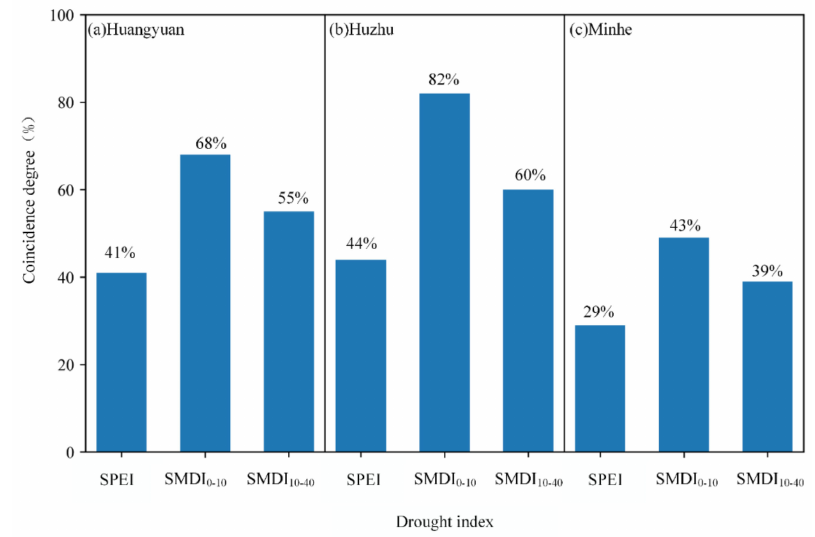
Figure 6. Coincidence degrees of identified drought events based on the selected drought